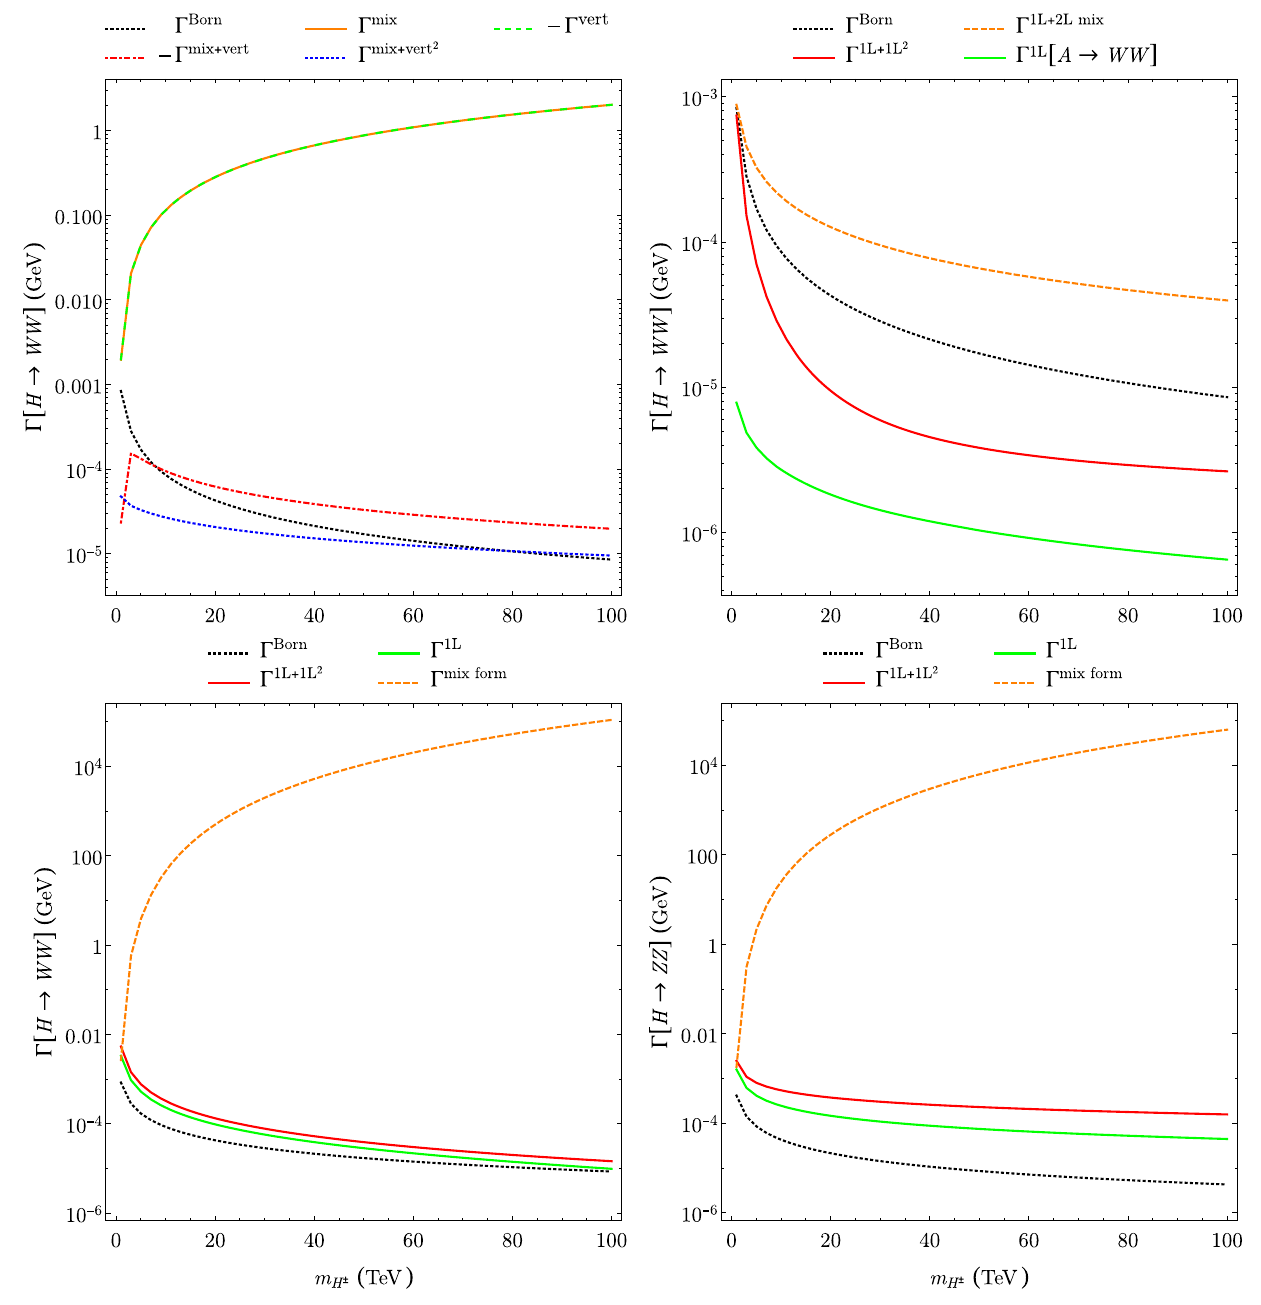
Fig. 10 Decay widths of heavy-doublet states into electroweak gauge bosons are displayed for t β = 10 and varying charged-Higgs mass (the SUSY sector is decoupled). Upper left: Individual contributions (cid:2) (cid:3) Y 2 q of order O to the decay of the heavy CP -even state; Born-level (dotted black), mixing-Born interference (orange), vertex-born inter- ference (absolute value, dashed green), (mixing+vertex)-Born interfer- ence (absolute value, dot-dashed red), 1L 2 term (dotted blue). Upper right: Varying definitions of the decay width with O